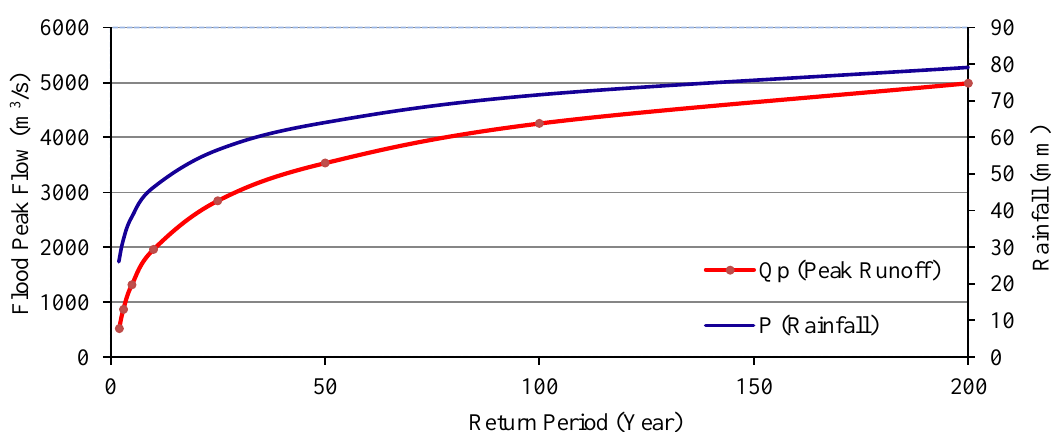
Figure 12. Graph of maximum 24-hour rainfall in Iranshahr catchment and its corresponding flood peak flow for return periods of 2 to 200